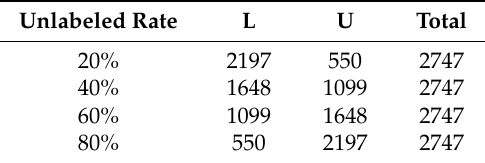
Table 2. Specific number of the labeled and unlabeled samples under different unlabeled